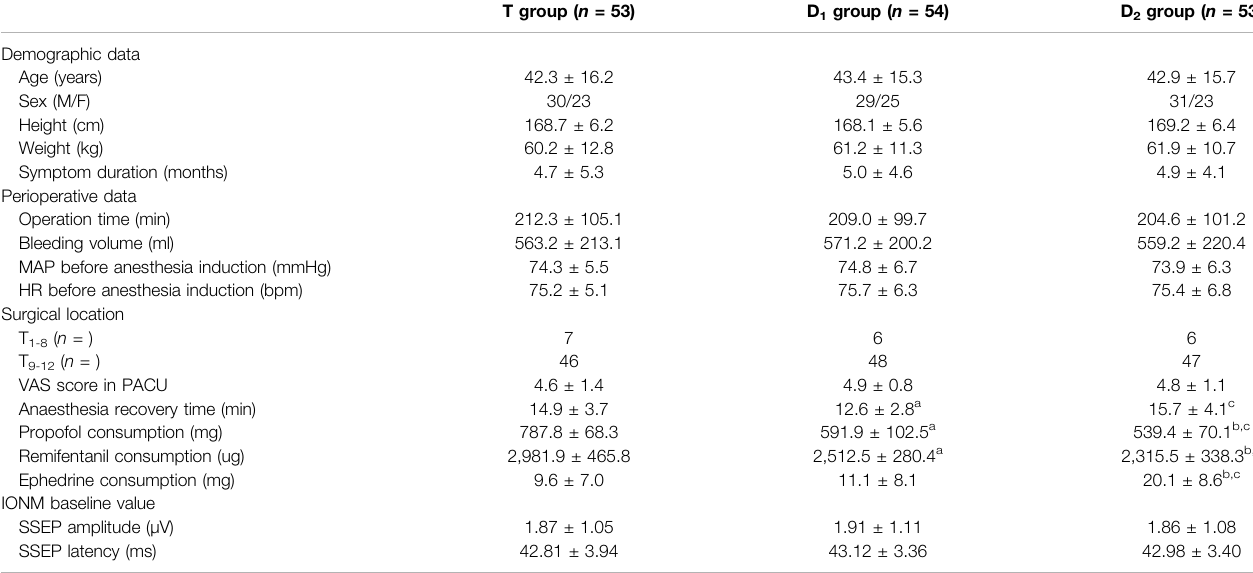
TABLE 1 | The general data of the three